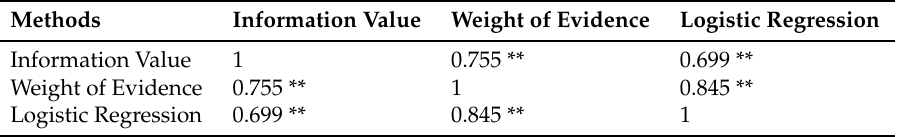
Table 5. Correlation between the